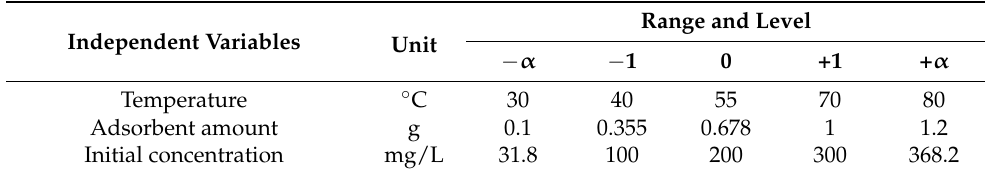
Table 1. Experiment design: experimental ranges and various levels of the variables for the batch system tests.